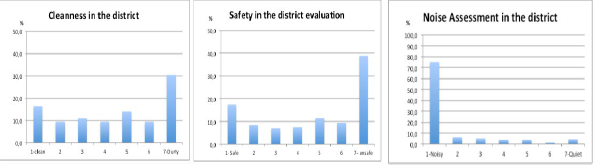
Fig. 11. District evaluation in terms of safety, cleanness and noise exposure.